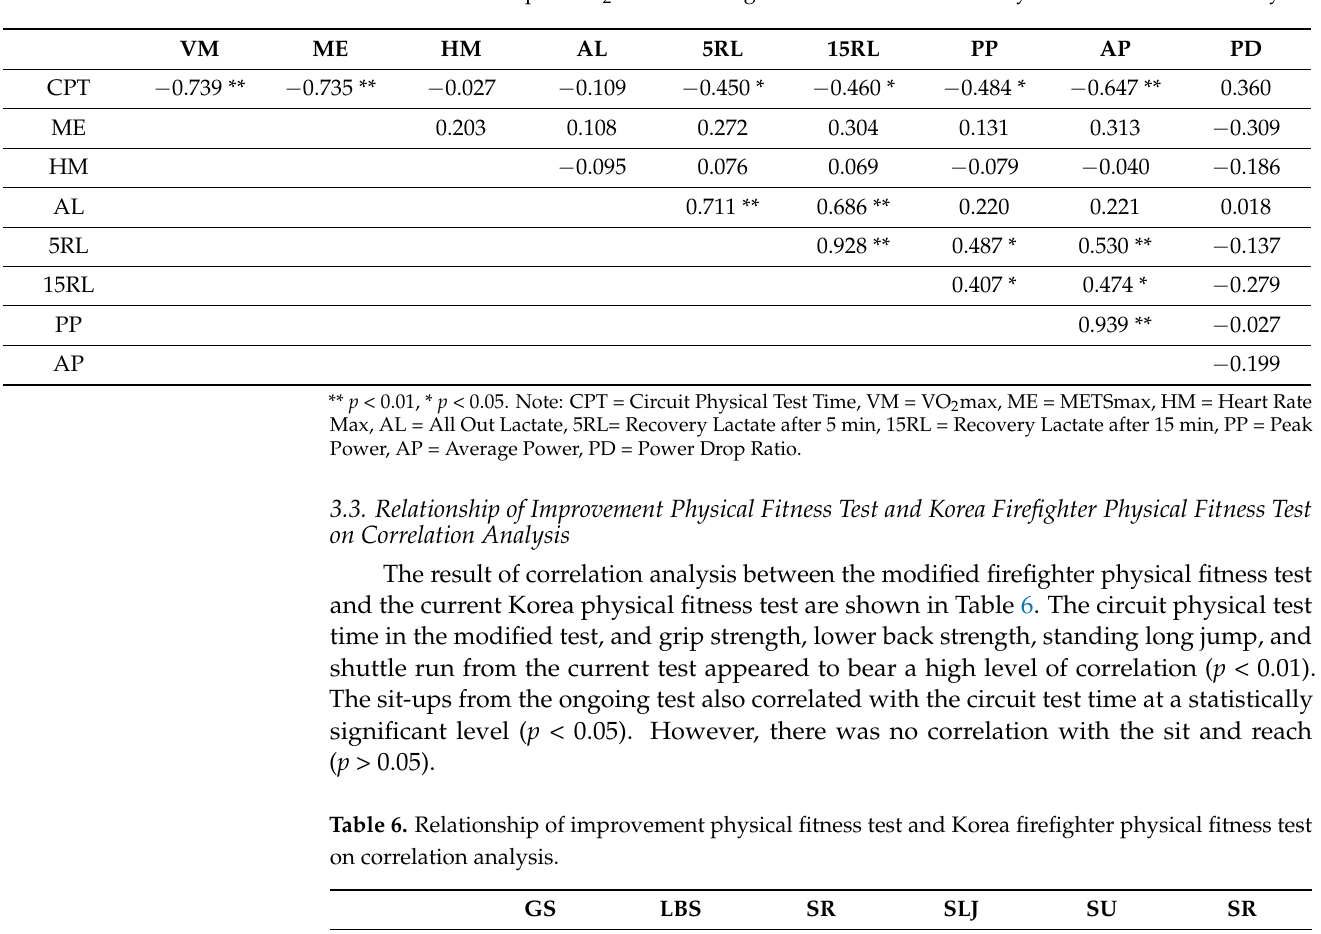
Table 5. Relationship of VO 2 max and Wingate test and lactate recovery ratio on correlation analysis.